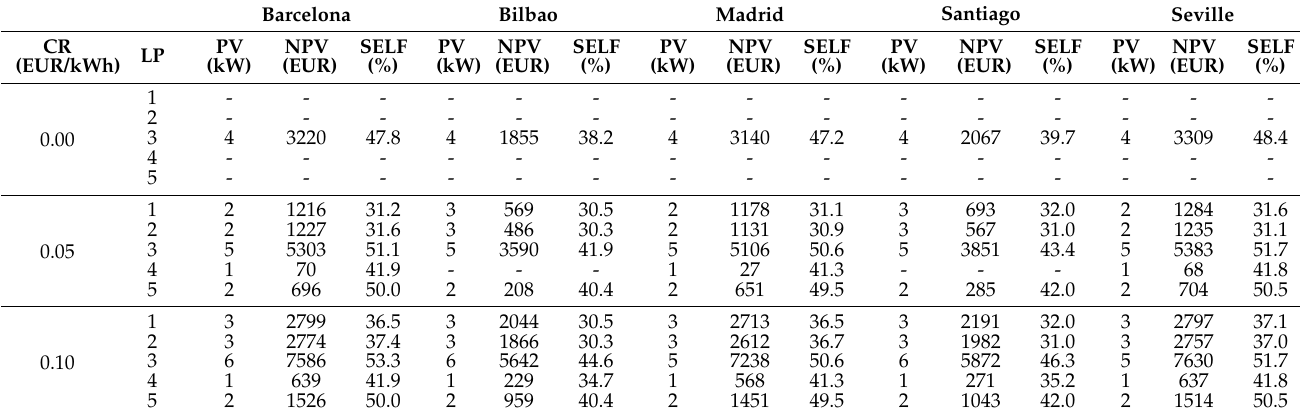
Table 3. Results of the computational experiment assuming profitability maximisation. CR: compensation rate.